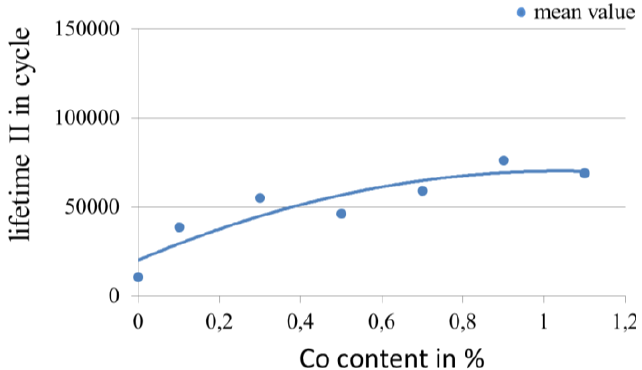
Figure 19. Effect of Co content in gold layer on lifetime in fretting and wear test. Number of measurements: 72.